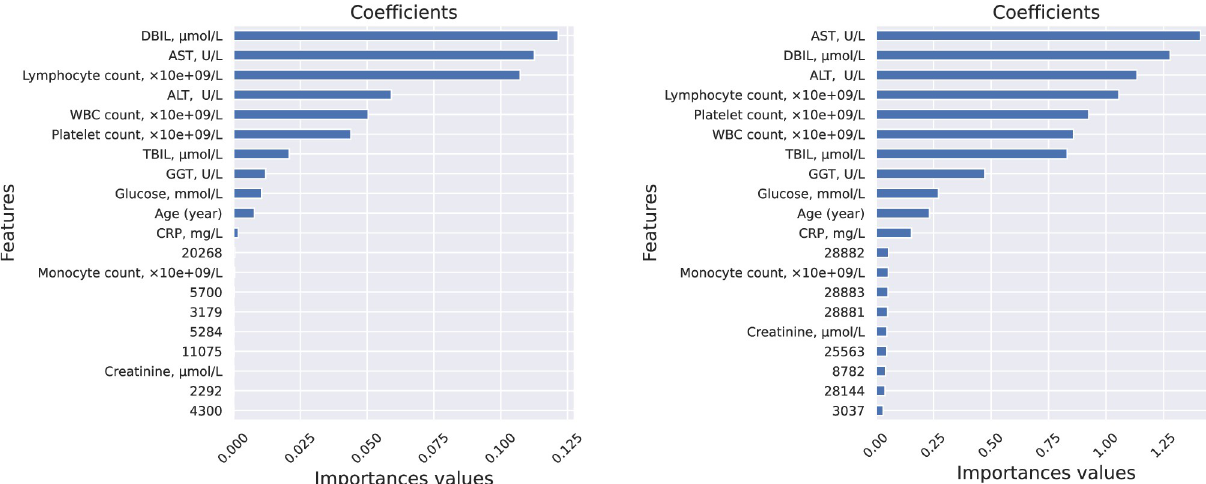
Fig 13. PFI and SHAP values for the feature importance analysis. The features from the biochemistry data have significantly higher scores than the features from the viral genome data for both approaches. The biochemistry data were generated separately for severe and non-severe cases, and therefore could have been identified by the model as most